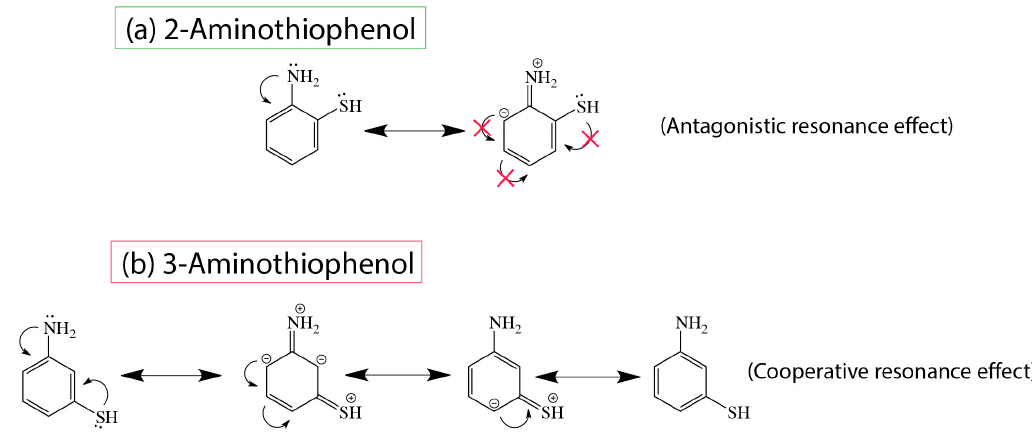
Figure 7. The resonance structures of ( a ) 2-aminothiophenol and ( b )